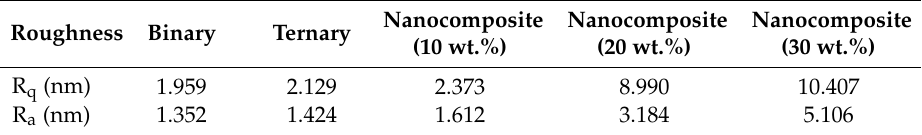
Table 1. Root mean square roughness (R q ) and average roughness (R a ) values for binary, ternary and nanocomposite thin films. Nanocomposite Roughness Binary Ternary (10 wt.%) (20